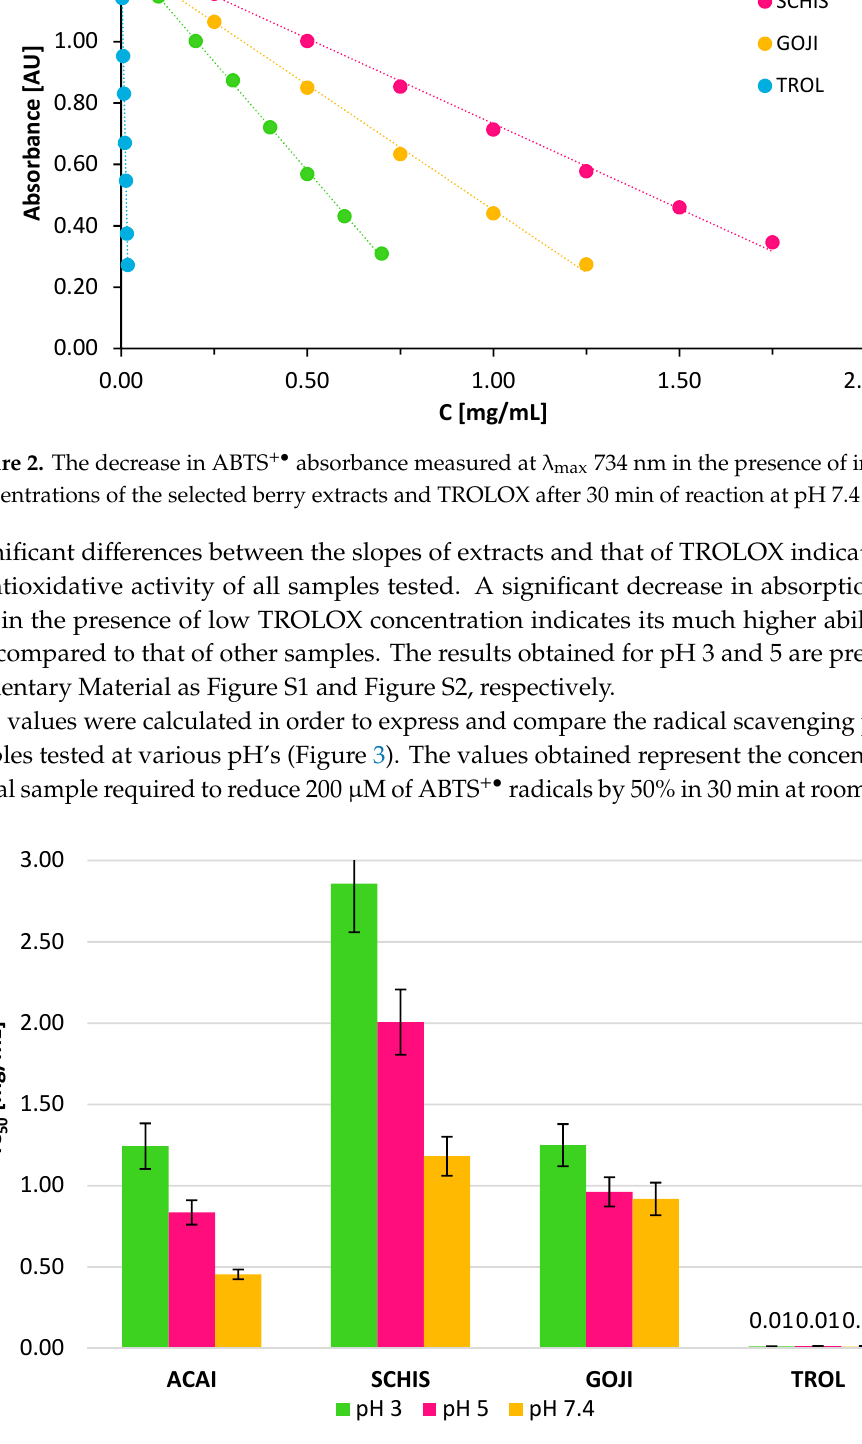
Figure 3. IC 50 values of the extracts tested and the TROLOX at various pH values.